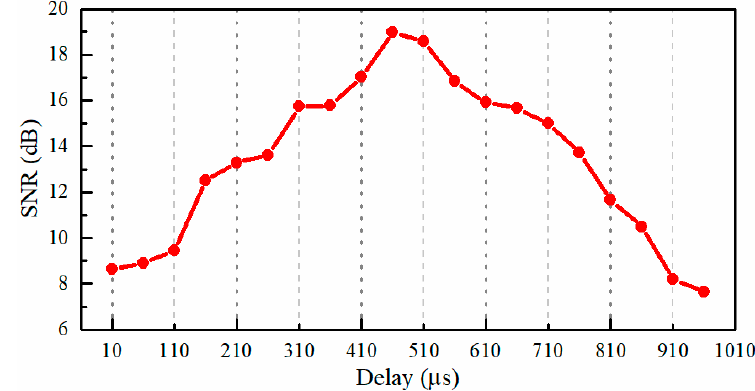
Figure 10. The dependence of the SNR (signal-to-noise ratio) of the recovered sinusoidal sound signal on the delay between the signals that trigger the CCD camera recording and DMD (digital micro-mirror device) modulation. The frequency of the sinusoidal voltage applied to the loudspeaker is 150 Hz, the rate of CCD image recording is 100 Hz, and the rate of DMD modulation is 800 Hz. Sensors 2018 , 18 , x